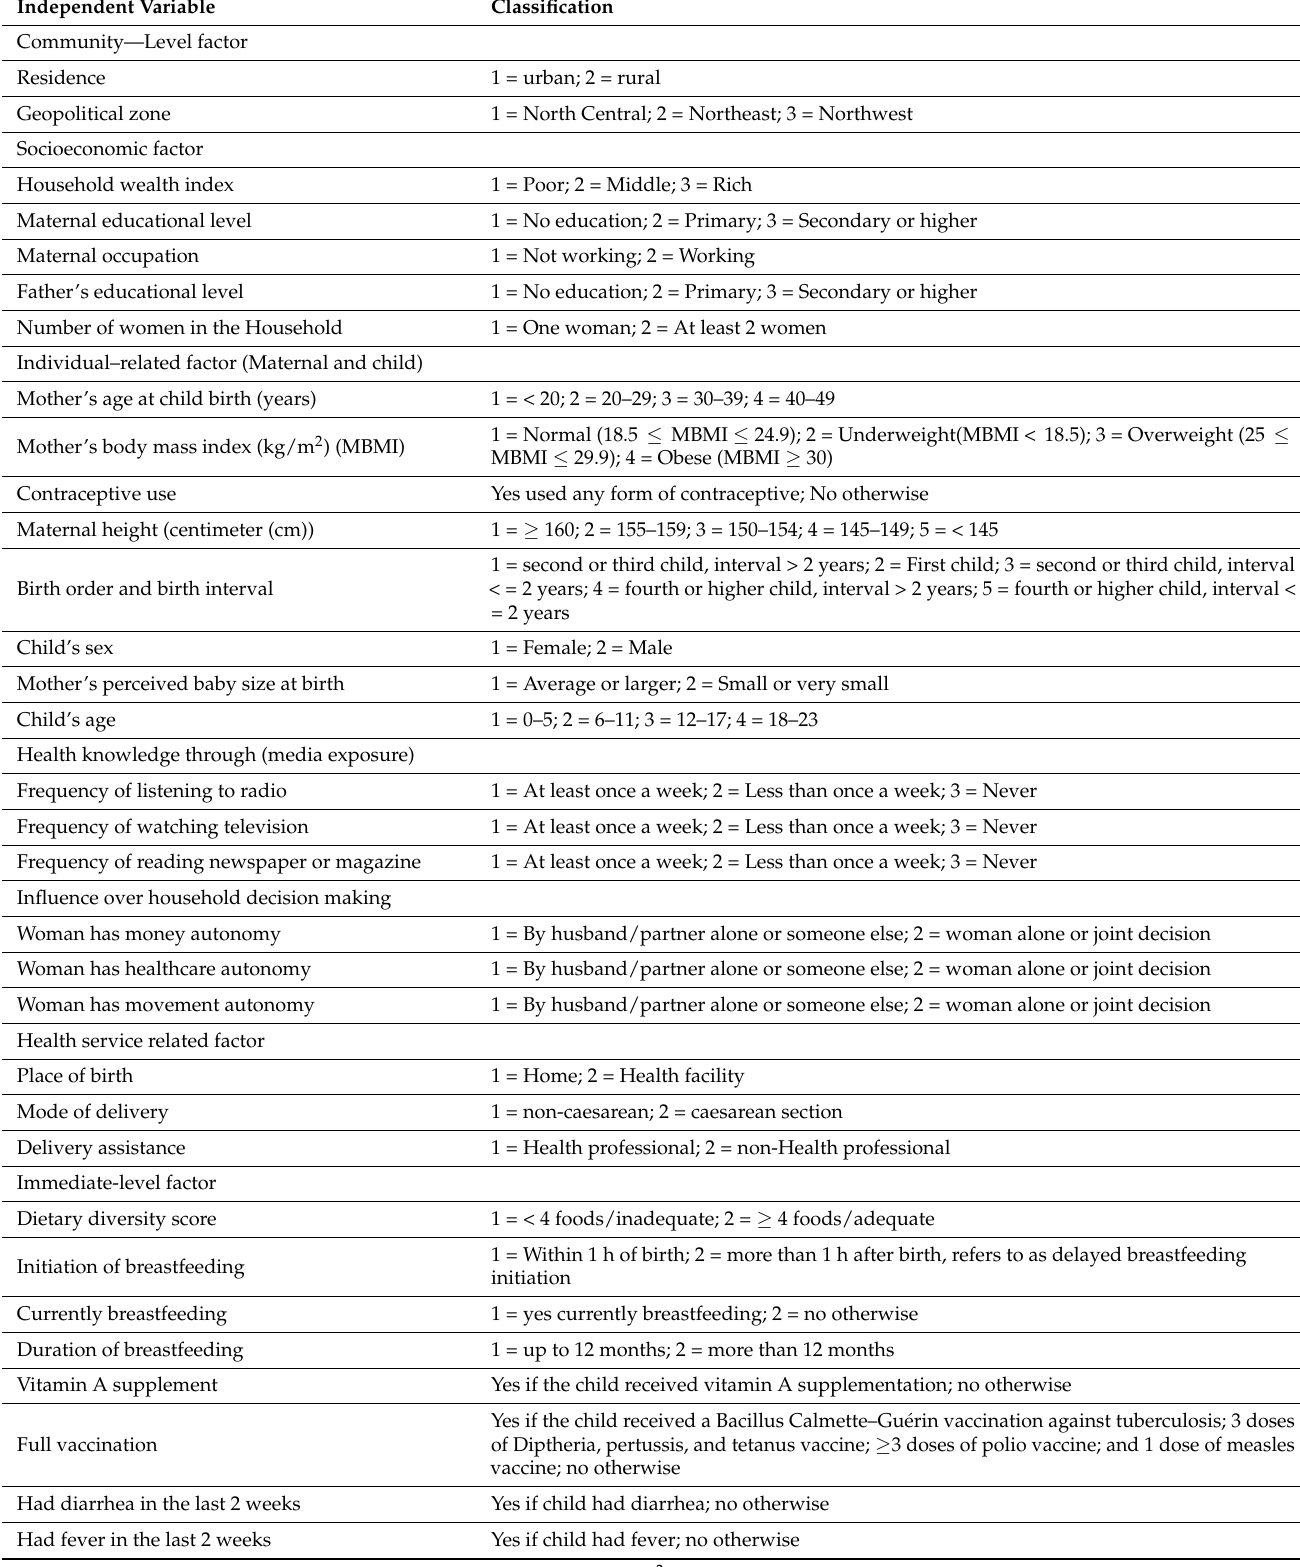
Table 1. Definition and classification of potential confounding factors related to child stunting for the study analysis. Independent